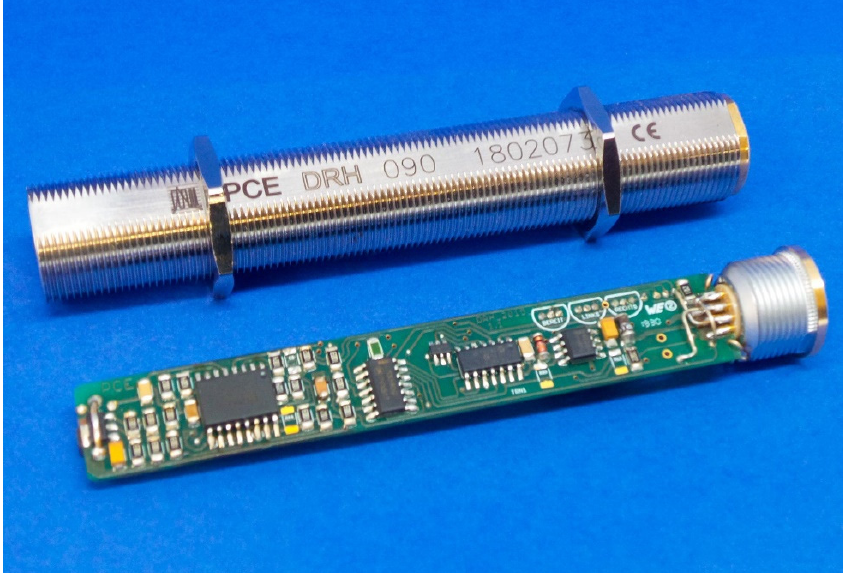
Figure 1. Commercially available sensor DRH 090 (Reprinted with permission from ref. [15]. 2021 PCE Process Control Electronic GmbH).